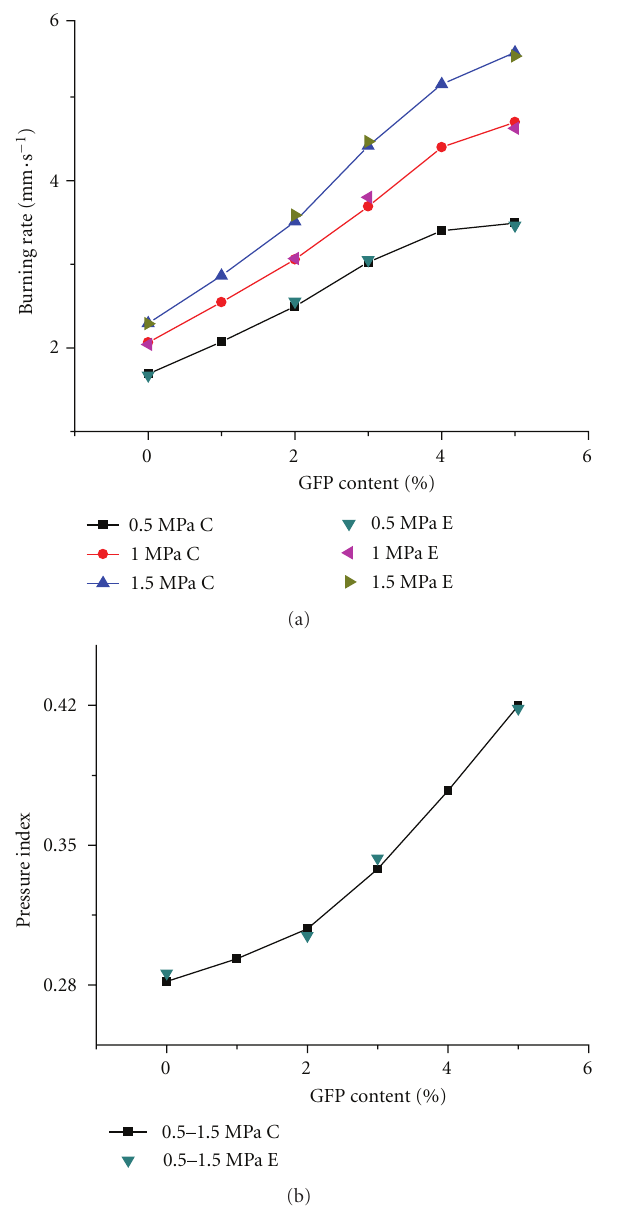
Figure 5: E ff ect of GFP content (wt%) on burning rate (a) and pressure index